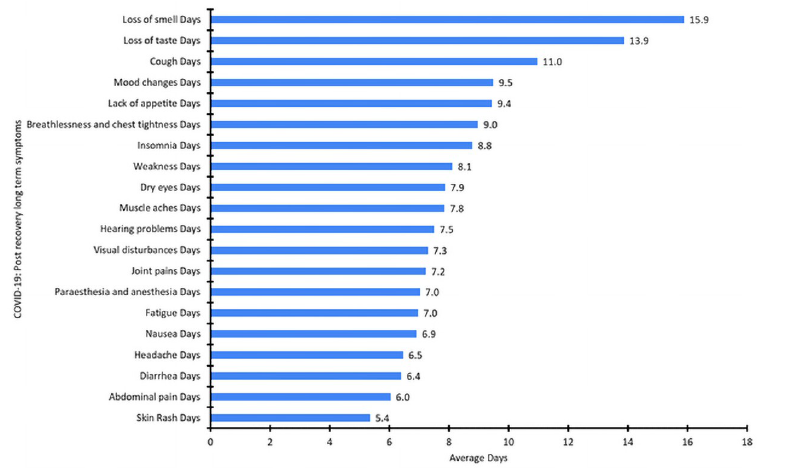
Fig 2. Average days for different COVID-19 post recovery long term